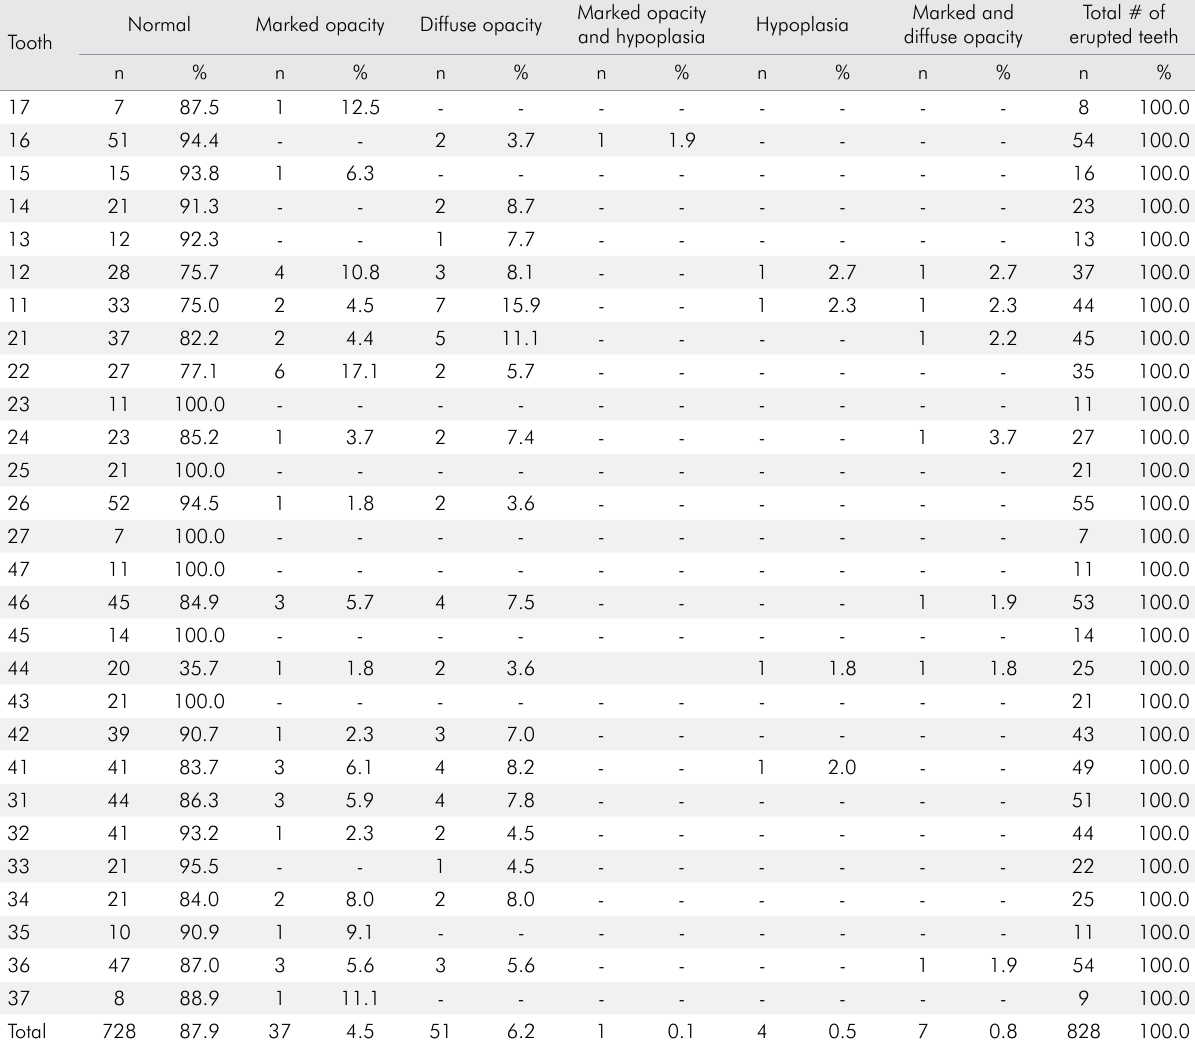
Table 1. Prevalence and distribution of enamel defects in erupted teeth.